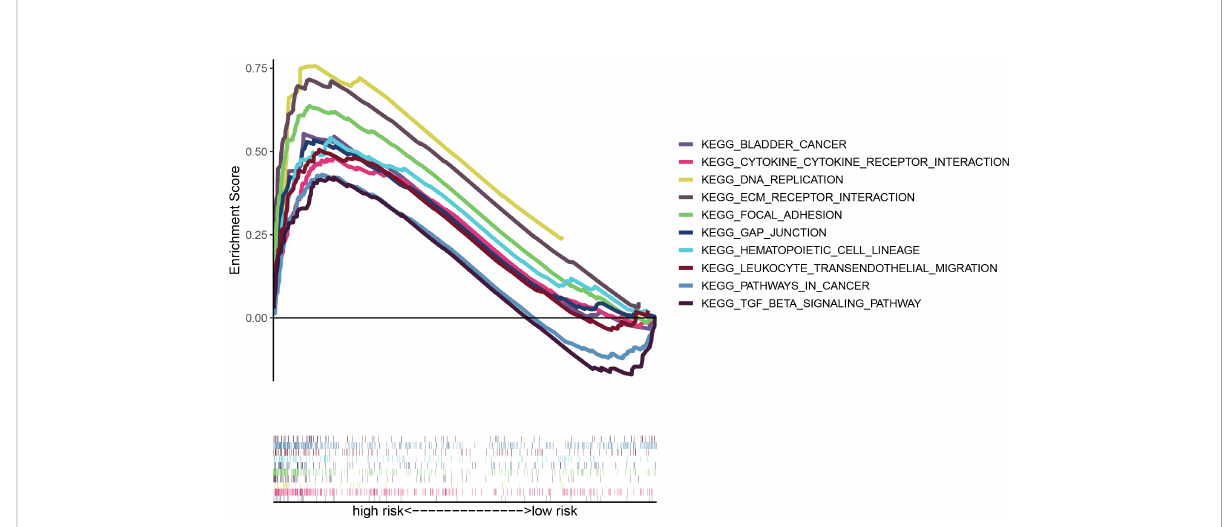
FIGURE 6 Multi-GSEA analysis of high- and low-risk patients in the risk